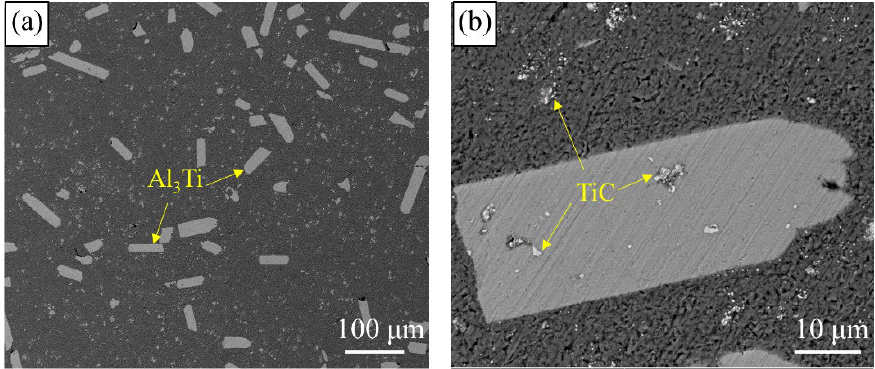
Figure 2. The morphology of grain refiner Al-5Ti-0.2C: ( a ) Overall distribution of Al 3 Ti in Al-5Ti-0.2C; ( b ) The distribution of TiC.